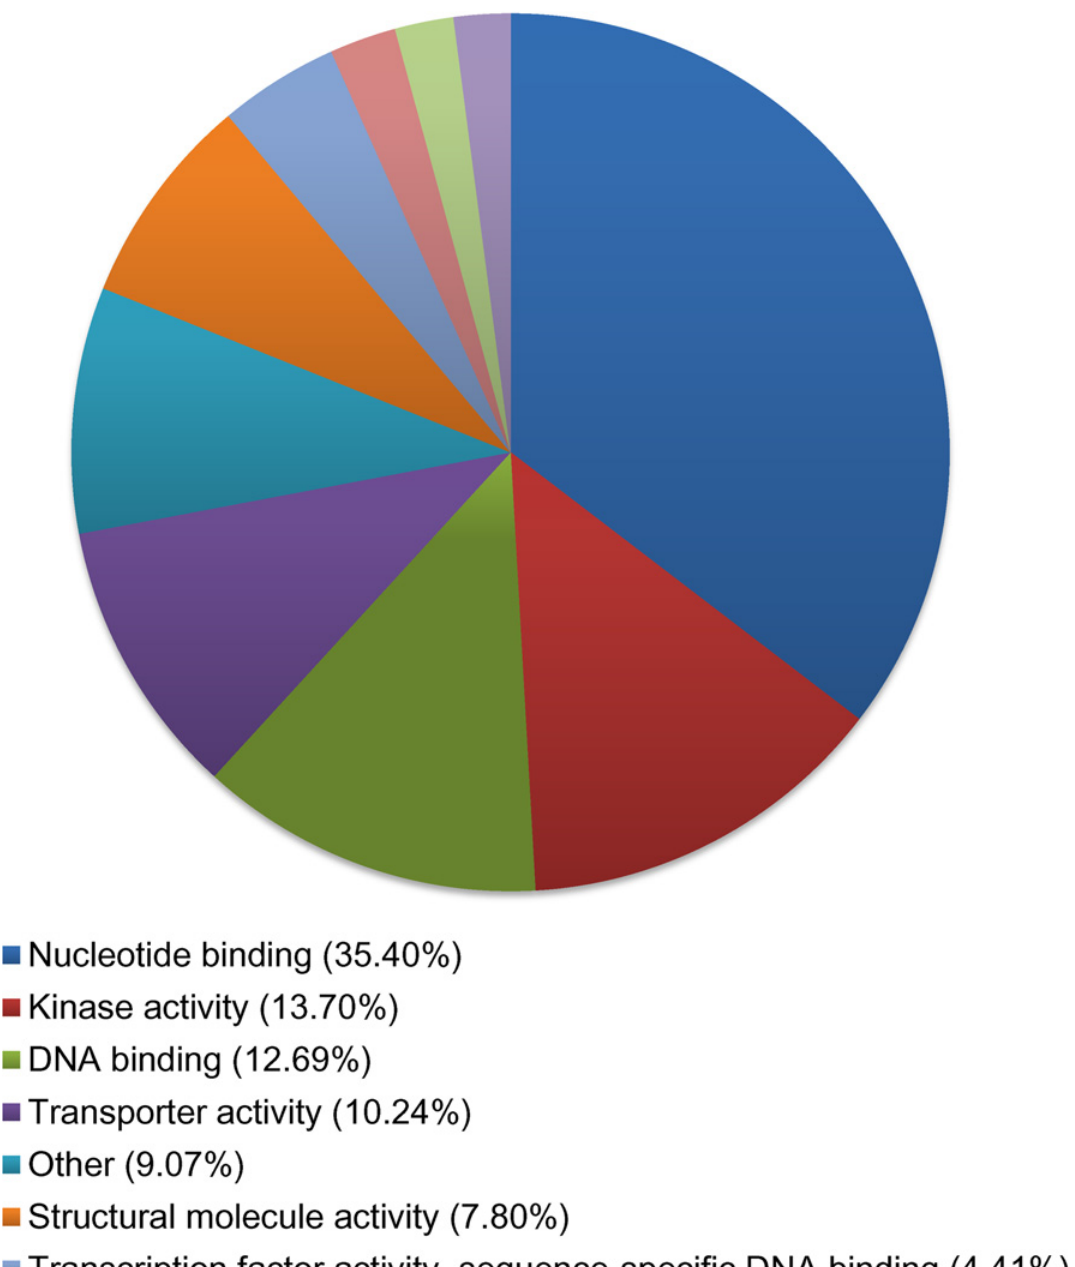
Fig 5. Percentage of transcripts in Betula papyrifera control samples. A total of 23,876 transcripts were assigned gene ontology and grouped by molecular function using BLAST2GO. Categories under 2% were grouped together and classified as “ other ” .